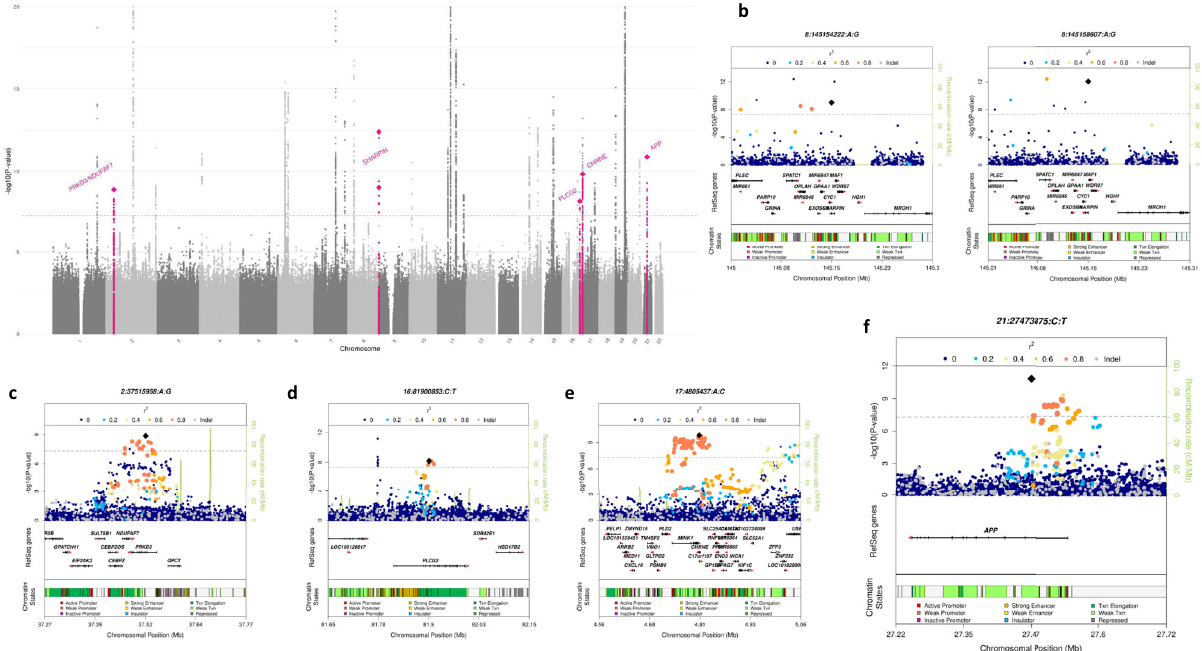
Fig. 2 GWAS meta-analysis for AD risk ( N = 467,623). a Manhattan plot of overall meta-analysis for genome-wide association in Alzheimer ’ s disease highlighting in pink the loci associated with AD in this study ( PRKD3/NDUFAF7, SHARPIN, CHRNE, PLCG2 , and APP ). b – f Locus plots for the signals associated with AD in overall meta-analysis